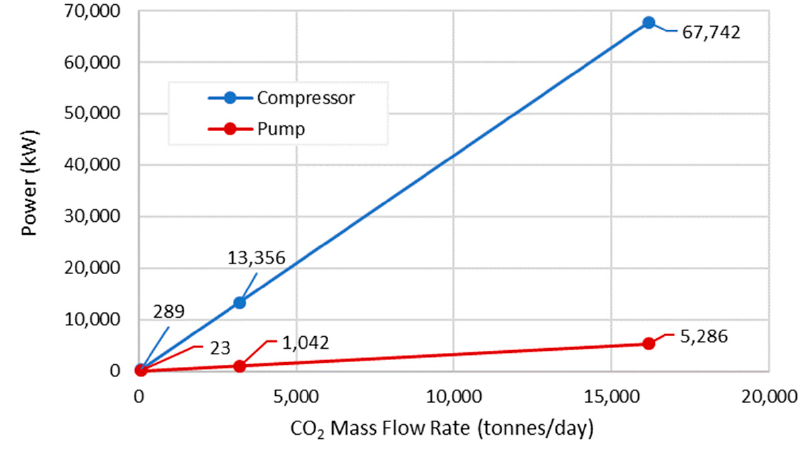
Figure 3. Power requirement of compression and pump as a function of CO 2 mass flow rate.